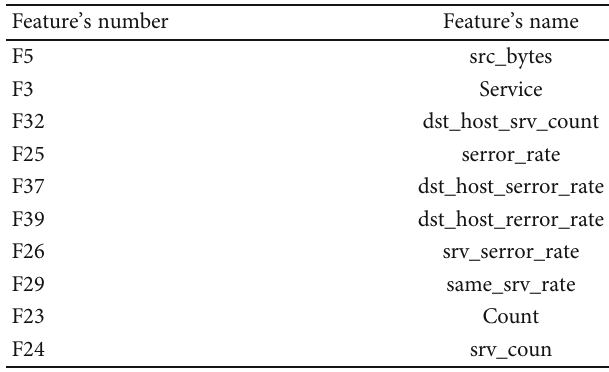
Table 3: Top ranked features of NSL-KDD using information gain